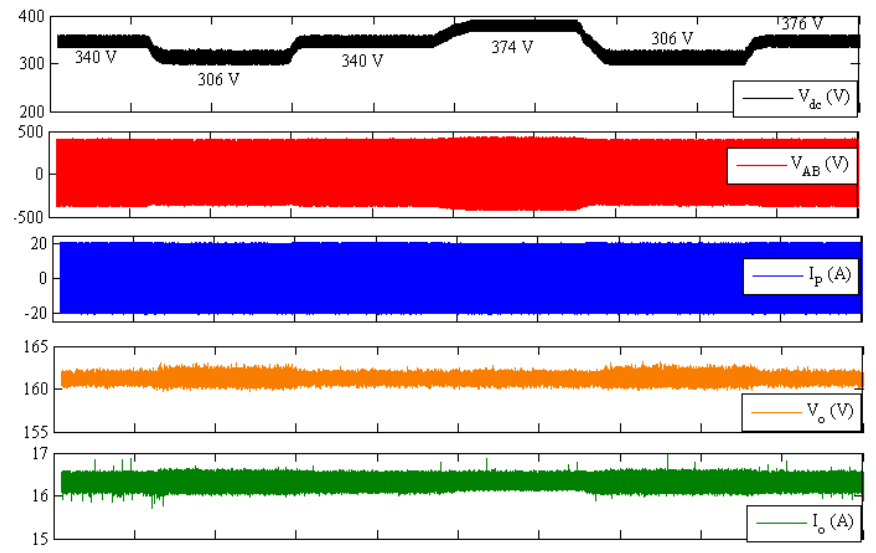
Figure 13. Experimental results for variation in DC input voltage.